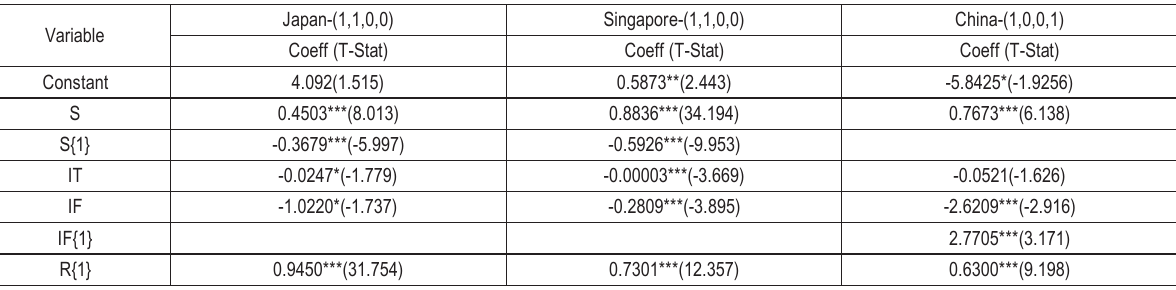
Table 4. The results of the long-run ARDL model